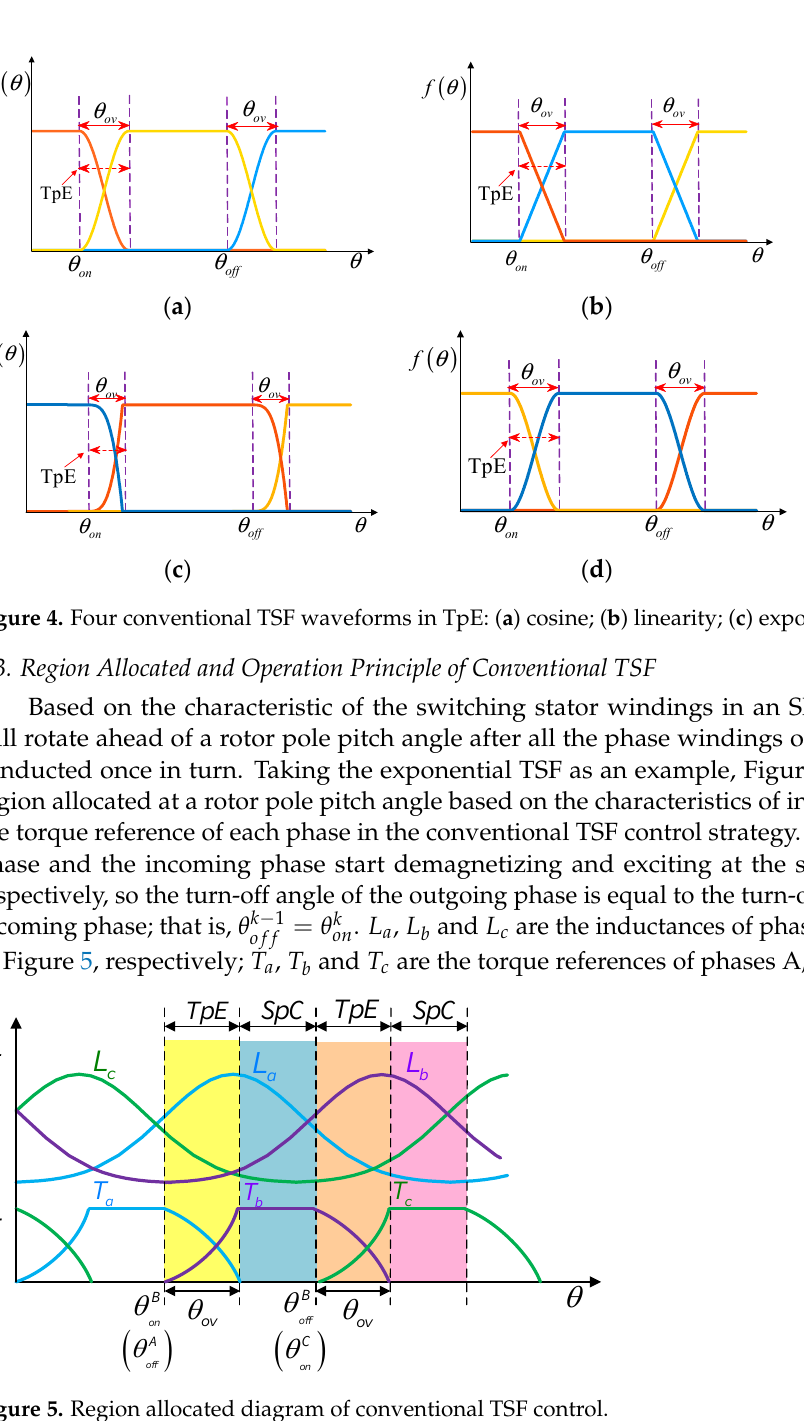
Figure 5. Region allocated diagram of conventional TSF control.